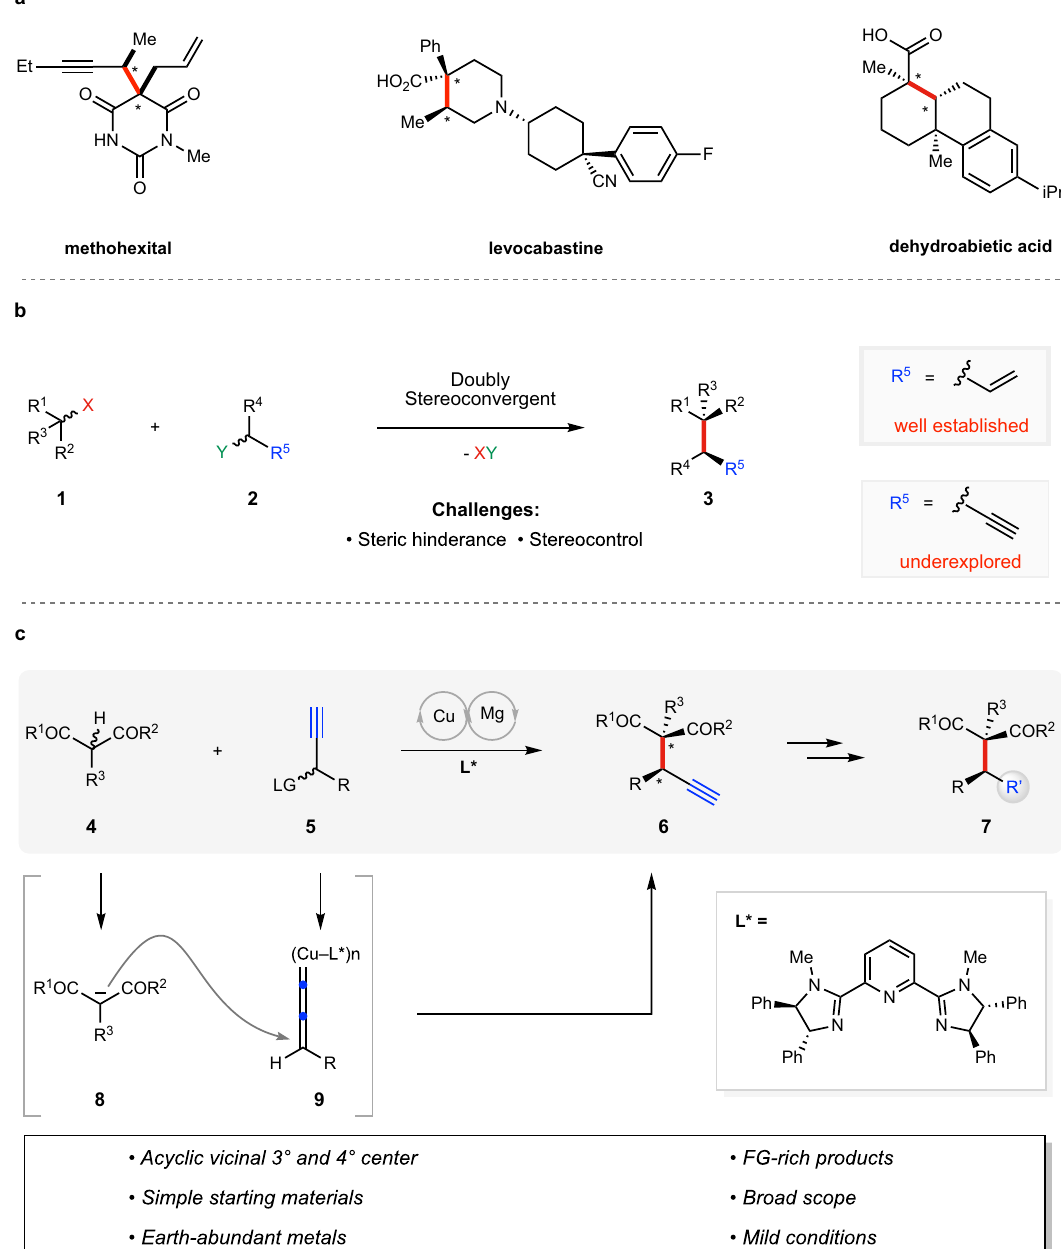
Fig. 1 Enantioselective construction of vicinal tertiary and all-carbon quaternary stereocenters. a Vicinal 3° and all-carbon 4° stereocenters in pharmaceutical agents. b Doubly stereoconvergent approaches to make vicinal stereocenters. c Cu/Mg-dual catalytic APS reaction to make vicinal 3° and 4° stereocenters (this